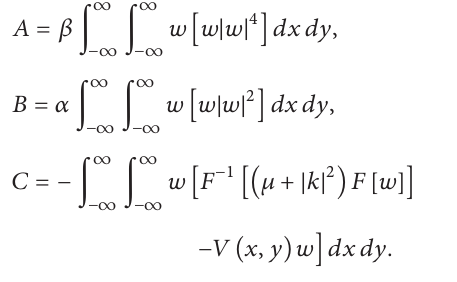
used for computing dissipative solitons without additional methods. But pseudospectral renormalization method only converges to the fundamental solitons. It diverges for excited states such as vortex solitons. Spectral renormalization method works well for the dipole and vortex solitons (see